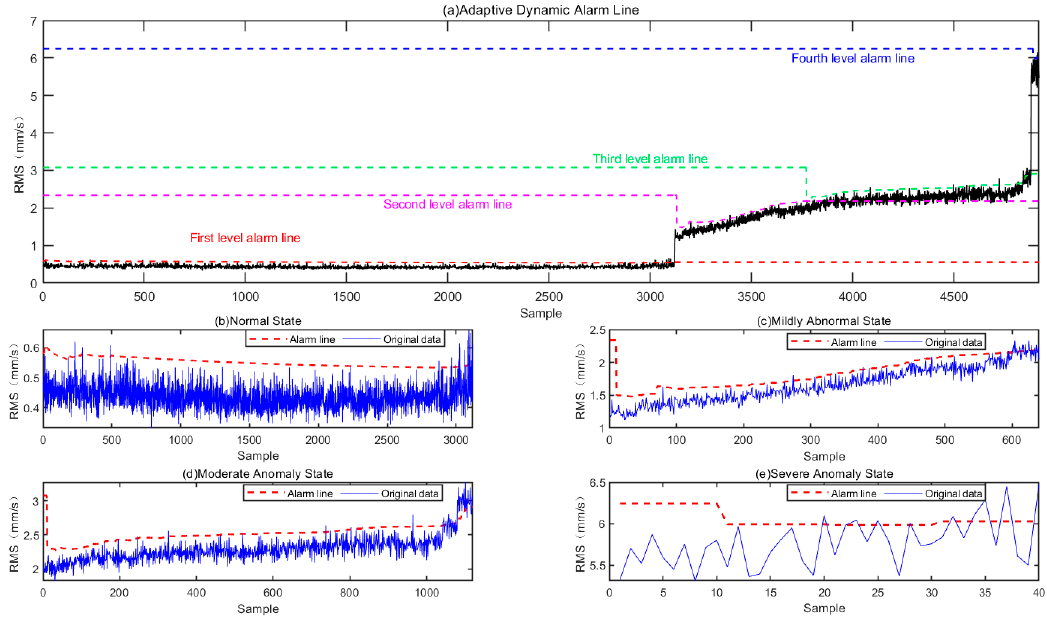
Figure 8. Adaptive dynamic alarm line in each state of the equipment.